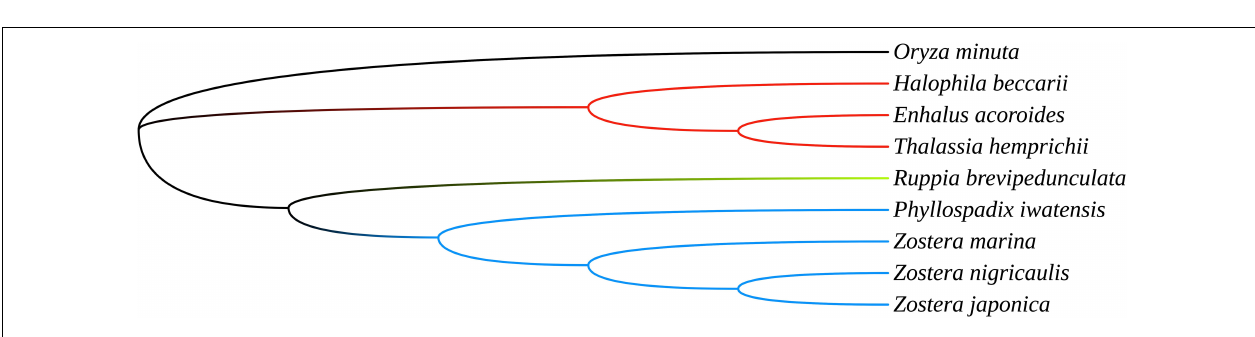
FIGURE 4 | Percentages of variable characters in homologous regions among the chloroplast genomes of four Zosteraceae species. (A) Coding region. (B) The introns and spacers (IGS). The homologous regions are oriented according to their locations in the chloroplast genome.